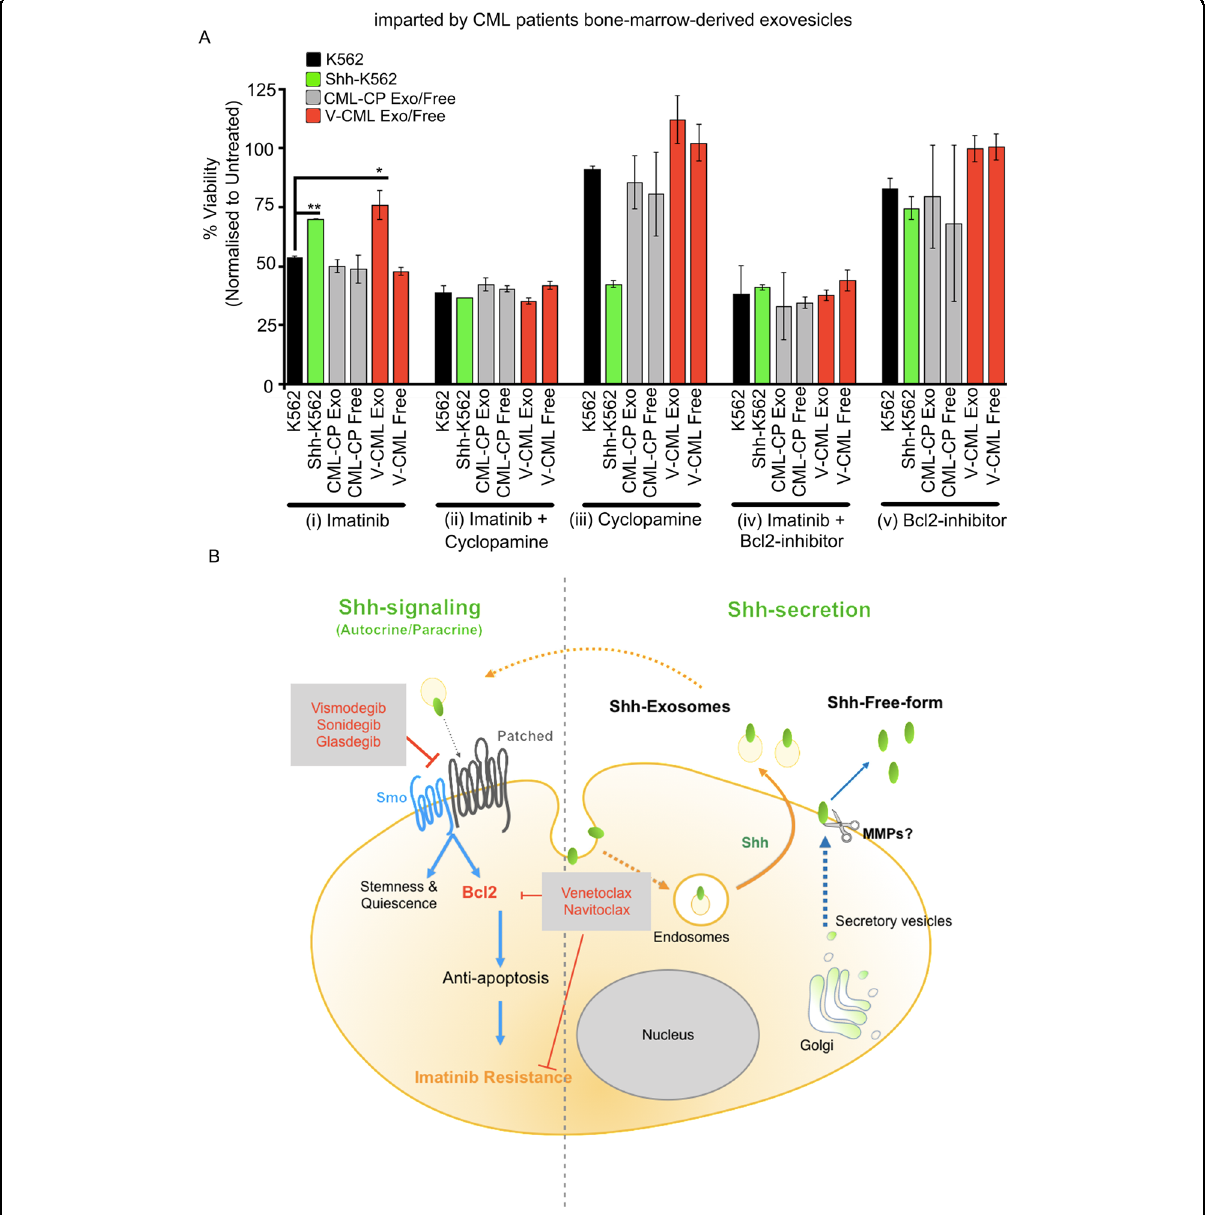
Fig. 7 Shh inhibitor or Bcl2 inhibitor can be used as adjuvants to overcome Imatinib resistance imparted by CML patient ’ s BM-derived exovesicles. A Viability of K562 cell line treated with Exo or free-fractions derived from CML-CP patients (CML-1 or CML-8) or V-CML (CML-4 or CML- 9) for 12 h, followed by treatment with 0.5 µM Imatinib ( i ), 25 nM Cyclopamine ( iii ), 50 nM Bcl2 inhibitor ( v ), or combined treatment (0.5 µM Imatinib + 25 nM Cyclopamine ( ii ) or 0.5 µM Imatinib + 50 nM Bcl2 inhibitor ( iv )) for 72 h. Data represent mean ± SD from two different CML patient-derived fractions. P values, *<0.05 and **<0.01. Statistical analysis done using t -test. B Cartoon representing mechanism of secretion of different extracellular forms of Shh and Shh-mediated Imatinib resistance in leukemic cells. Available FDA-approved drugs indicated in red text, which can be used to overcome Shh-mediated therapy